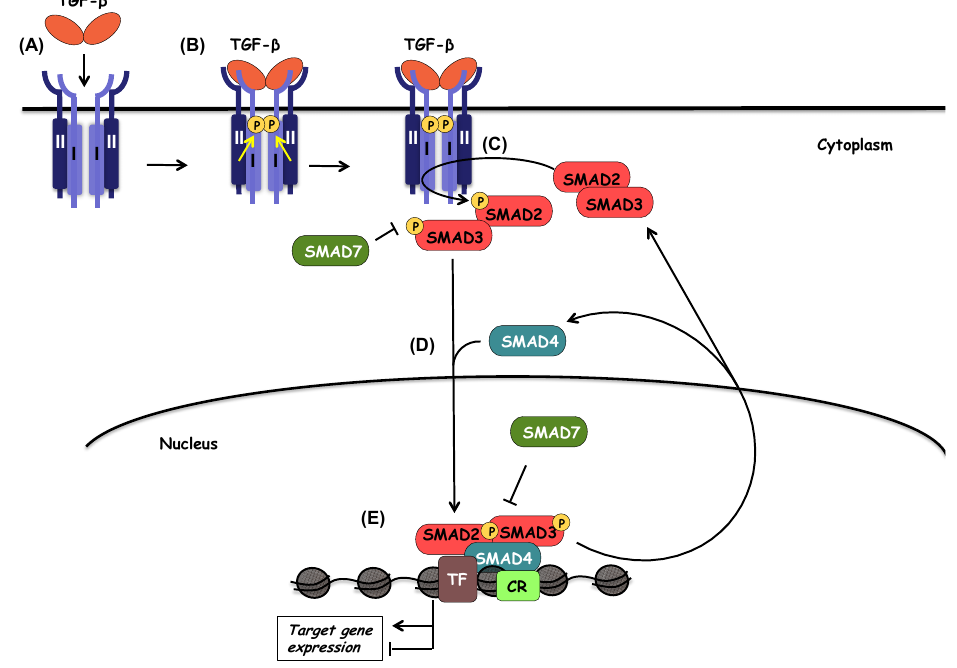
Figure 3. The TGF- β / SMAD signaling pathway. During the first steps of TGF- β signaling, TGF- β ligand binds to a heteromeric complex of type II, and type I receptors ( A ). Upon ligand binding, type II receptor phosphorylates and activates type I receptor ( B ). Activated type I receptor in turn phosphorylates and activates the receptor-activated SMADs (R-SMADs), SMAD2 and SMAD3 ( C ). SMAD7 competes with R-SMADs for interacting with type I receptor, thus preventing R-SMAD activation and proper propagation of the signaling. Activated R-SMADs dissociate from type I receptors in order to form a complex with the common mediator SMAD4 ( D ). The trimeric complex translocates to the nucleus where it associates with high-affinity DNA binding transcription factors (TF) and chromatin remodeling proteins (CR) in order to positively or negatively regulate the transcription of target genes ( E ). SMAD7 can also inhibit the transcriptional activity of the nuclear SMAD complex.